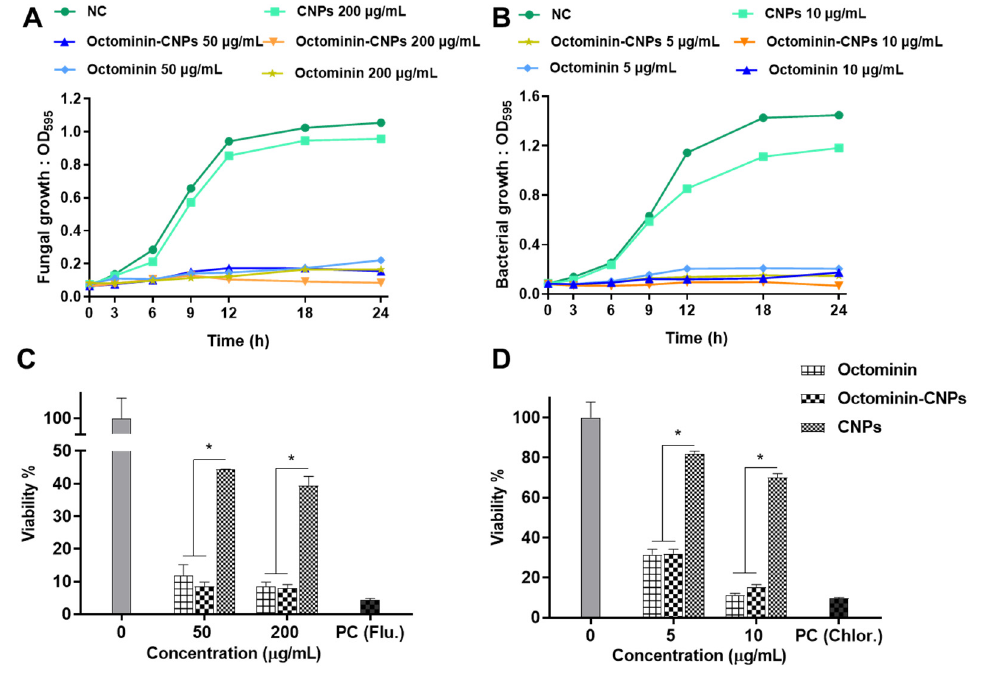
Figure 3. Time-kill kinetics and fungal/bacterial viability analysis with the treatment of Octominin- CNPs, Octominin, and CNPs. Octominin-CNPs, Octominin and CNPs were treated for ( A ) Candida albicans at 50 (minimum inhibitory concentration; MIC) and 200 µg/mL (minimum fungicidal con- centration; MFC) and ( B ) Acinetobacter baumannii at 5 (MIC) and 10 µg/mL (minimum bactericidal concentration; MBC). Fungal/bacterial growth was measured with an optical density at 595 nm (OD 595 ) at 0, 3, 6, 9, 12, 18, and 24 h and derived time-kill kinetic graphs. Viability assay of ( C ) C. albicans and ( D ) A. baumannii with treatments of Octominin-CNPs, Octominin, and CNPs. Fungi/bacteria were treated with MIC and MFC/MBC levels of Octominin-CNPs or Octominin or CNPs, and viability was measured using an MTT assay after 24 h of treatment. * p < 0.05, The error bars indicate the mean ± SD (n = 3). OD 595 ; optical density at 595 nm, NC—negative control, PC—positive control, Flu—Fluconazole, Chlor—Chloramphenicol.